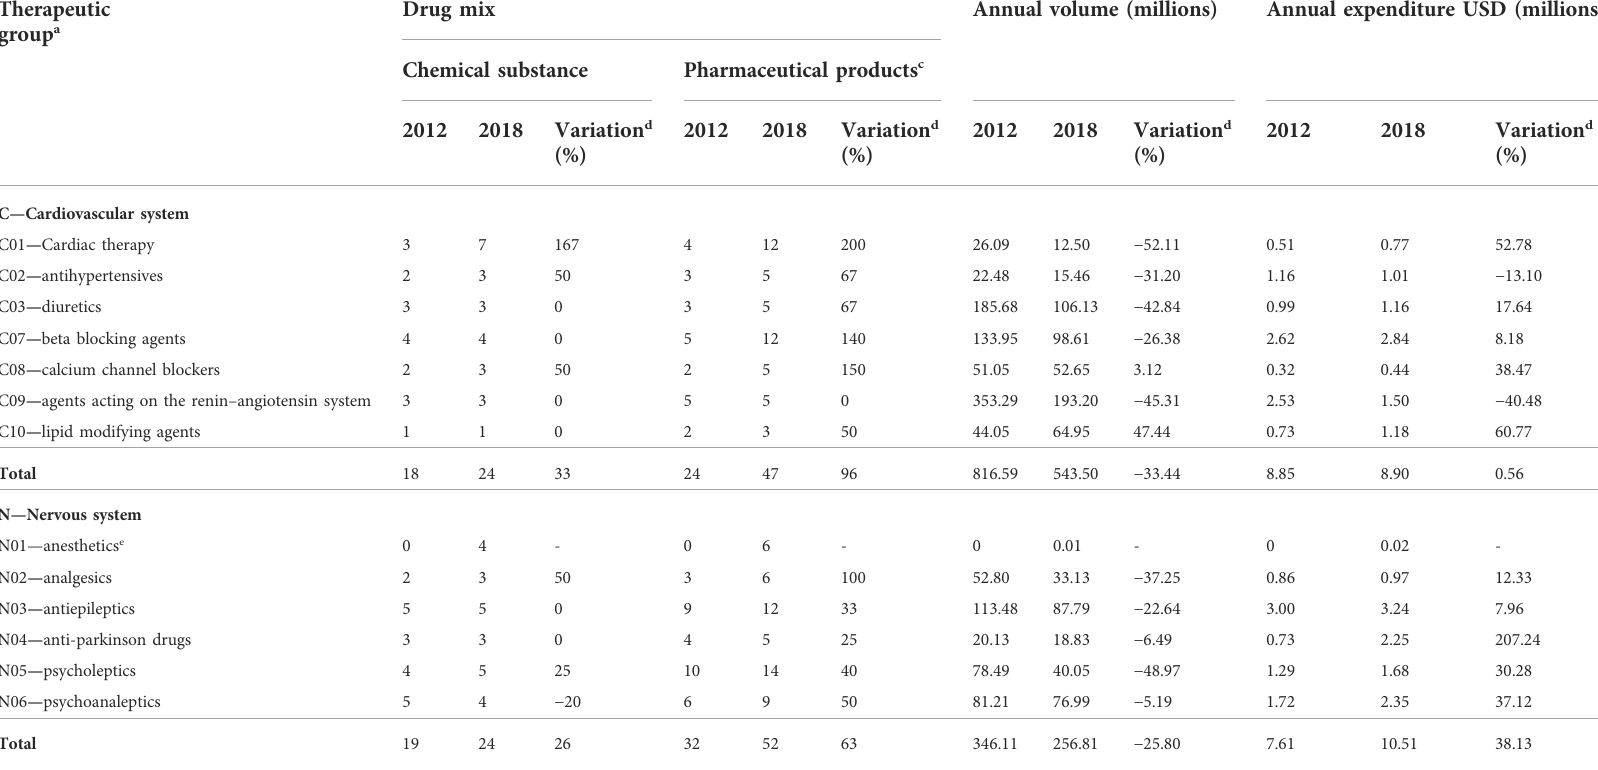
TABLE 3 Cardiovascular and nervous system groups, drug mix, annual volume, and expenditure in 2012 and in 2018 and variations in the period. Minas Gerais, Brazil. Therapeutic group